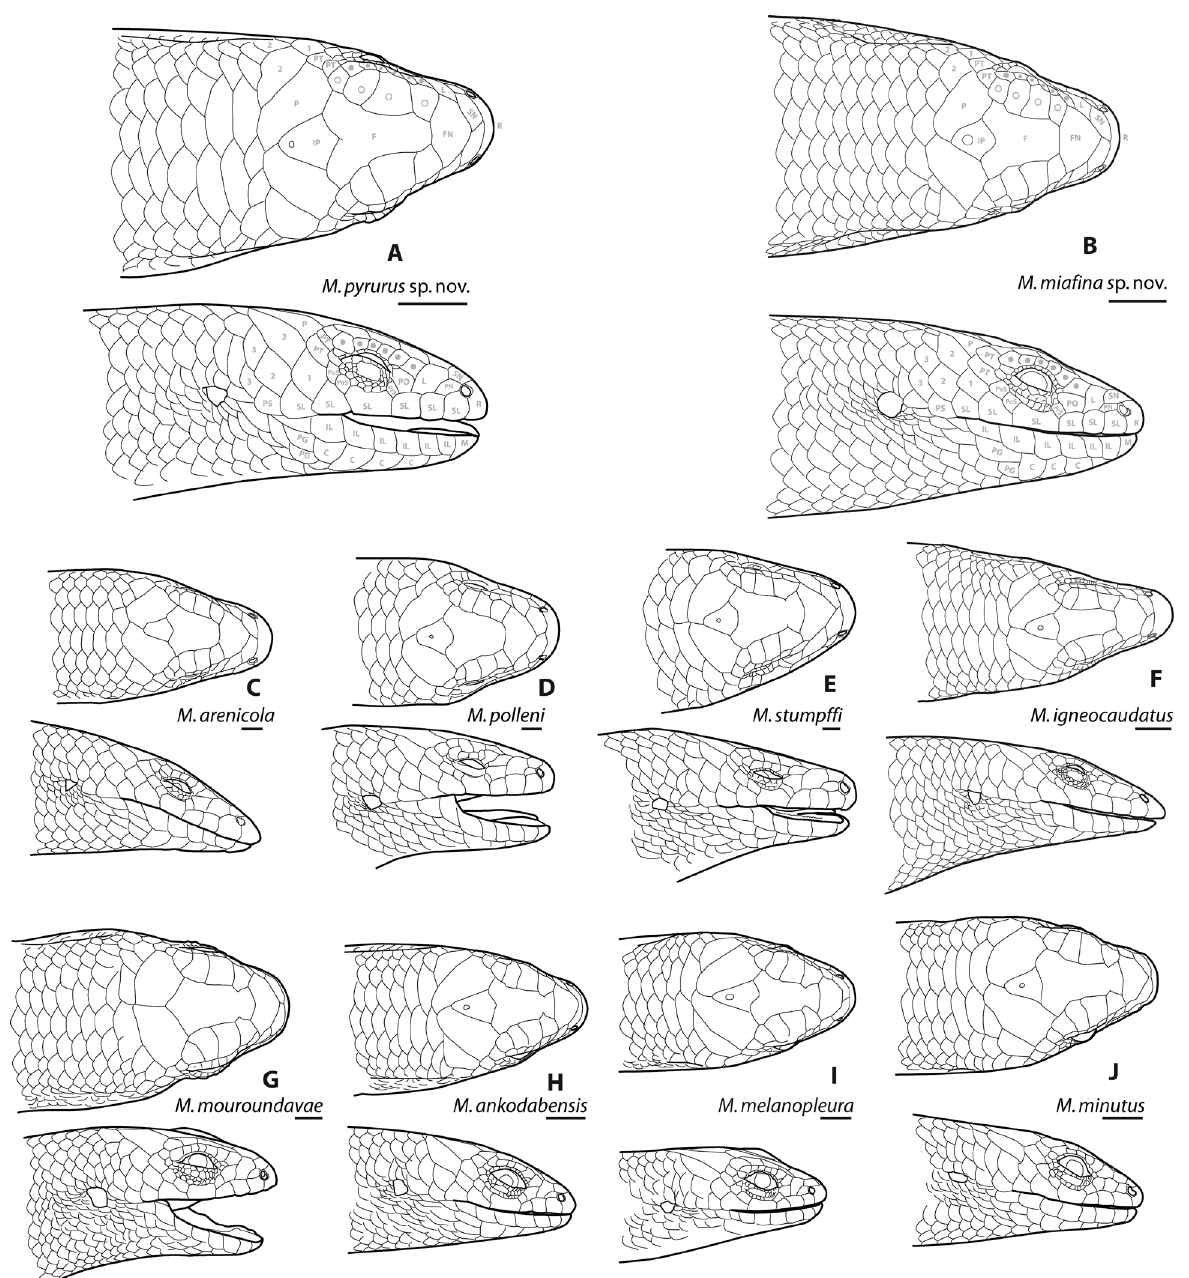
Figure 3. Drawings of the lateral and dorsal views of the heads of most of the species of Madascincus , including the holotypes of the two new species described herein. A : Madascincus pyrurus sp. n., holotype ZSM 520/2001 (MV 2001-445), Mont Ibity; B : M. mi- afina sp. n., holotype ZSM 1562/2008 (FGZC 1658), Ankarana Special Reserve; C : M. arenicola , holotype ZSM 1565/2008 (FGZC 1703), Baie des Sakalava; D : M. polleni , holotype MNHN 1895.210, “ Mouroundava ” (= Morondava); E : M. stumpffi , holotype SMF 16019, “ Nossibé ” (=Nosy Be); F : M. igneocaudatus , ZSM 1600/2010 (ZCMV 12888), Anakao; G : M. mouroundavae , ZSM 13/2005 (ZCMV 2254), Andasibe; H : M. ankodabensis , ZSM 355/2006 (ZCMV 2907), Ranomafana; I : M. melanopleura , ZSM 20/2005 (ZCMV 2266), Andasibe; J : M. minutus , ZSM 400/2005 (ZCMV 2166), Nosy Mangabe. Dwarf species of Madascincus , namely M. nanus and M. macrolepis , not represented. Scale bars = 2 mm. Abbreviations used for indication of scales ( A, B ) follow those defined by Miralles et al.